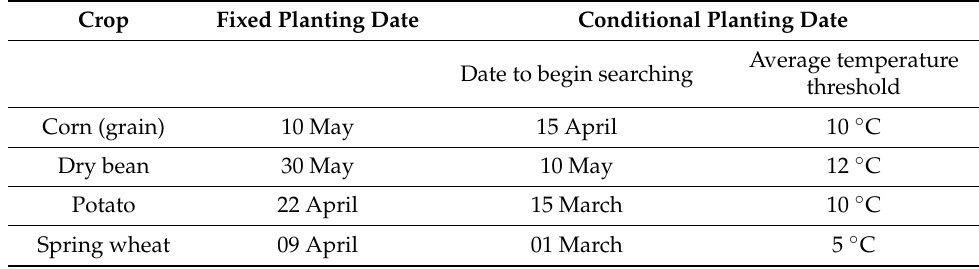
Table 2. Traditional planting date and the criteria for conditional planting date for annual crops 1 . Crop Fixed Planting Date Conditional Planting